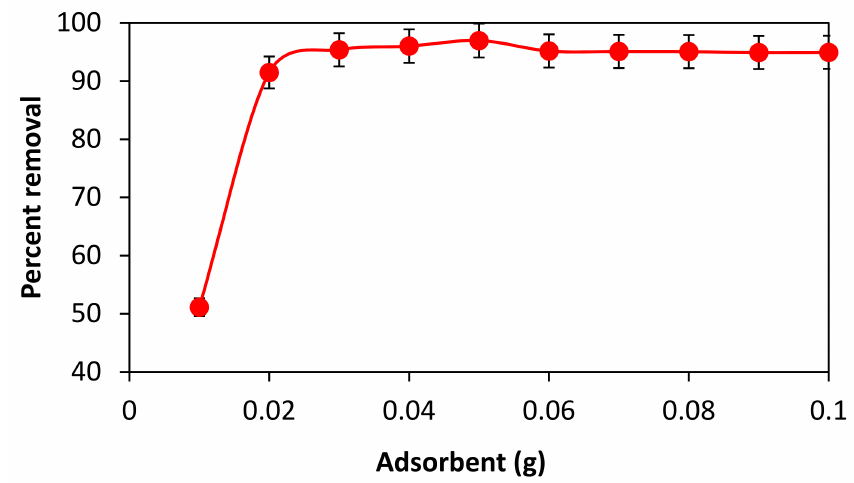
Figure 3. Effect of adsorbent dose on percent removal of BG